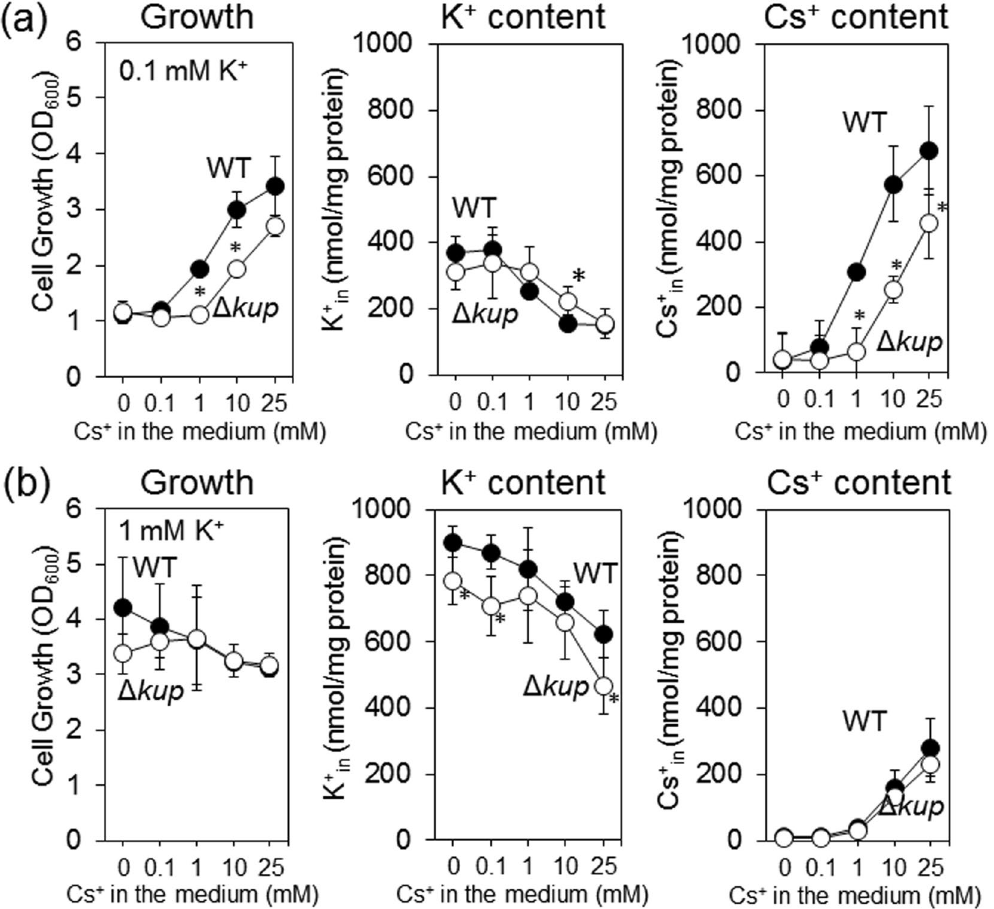
Figure 2. Determination of growth and K + or Cs + accumulation of E . coli WT and Δ kup . E . coli WT and Δ kup were grown in minimal medium supplemented with 0.1 mM K + ( a ) or 1 mM K + ( b ) and various Cs + concentrations for 24 h at 30 °C. At that time, OD 600 as well as intracellular K + and Cs + content were determined. The error bars represent mean ± S.D. (n = 4). * Represents significance by Student’s t -test comparing WT to Δ kup at the same concentration ( P <